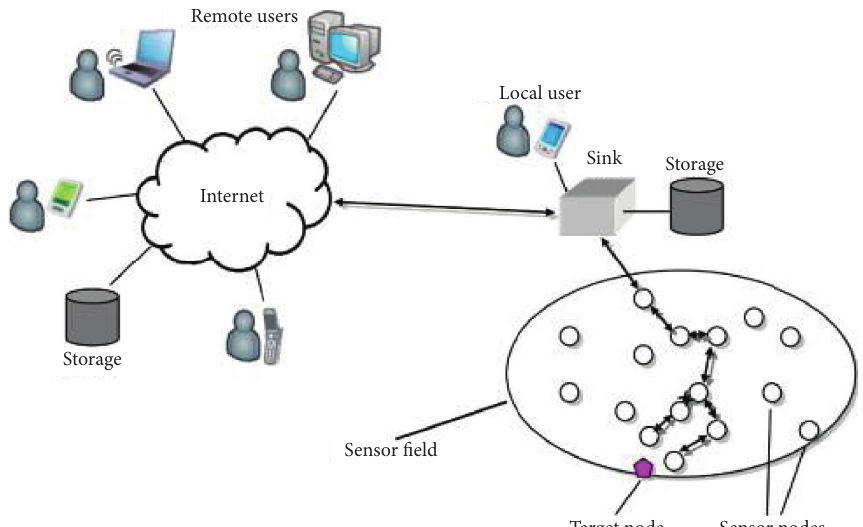
Figure 3: Sensor network application in field source